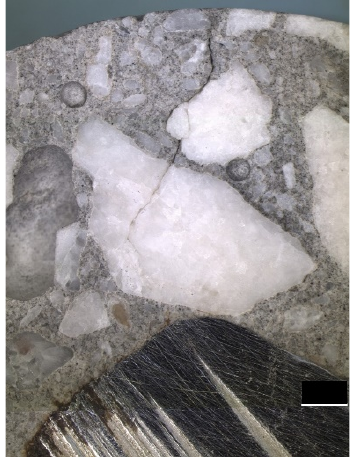
Figure 6. Microscopic image of polished cross sec- tion from a cracked specimen reinforced with CS bar, after corrosion